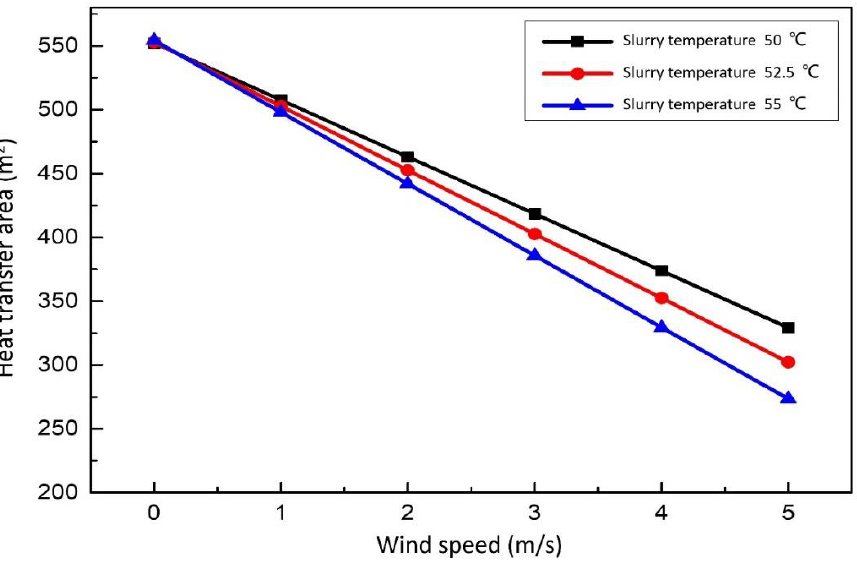
Figure 10. Effect of wind speed on the heat transfer area.